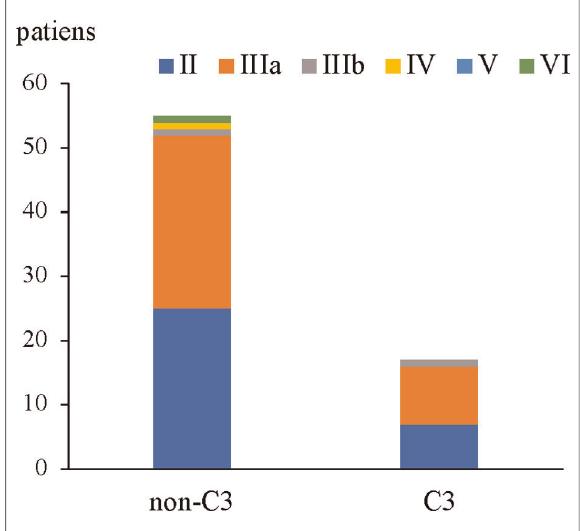
FIGURE 4 Renal pathological grades for patients with or without glomerular C3